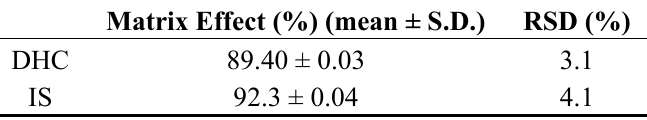
Table 4. Matrix effects data for DHC at 25.0 ng/mL and IS 200 ng/mL in six different sources of rat